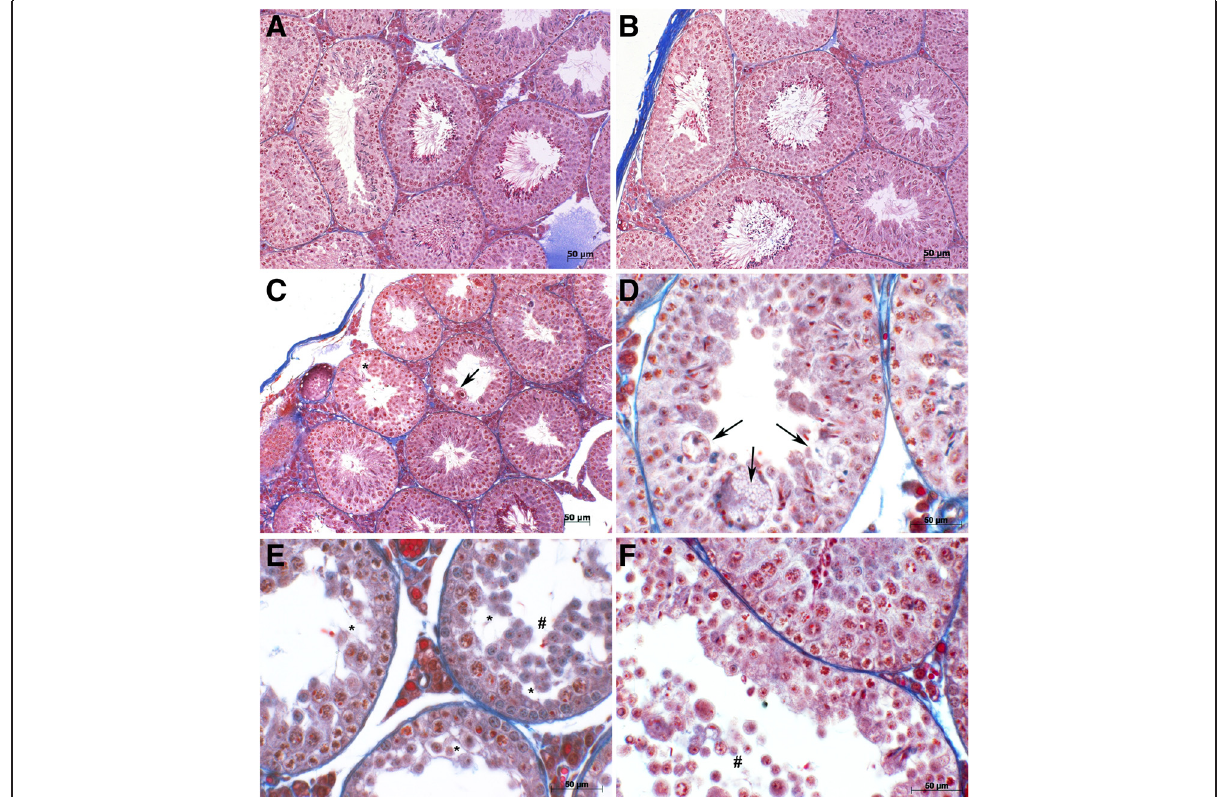
Figure 1 Morphological analysis of the seminiferous epithelium of male adult mice treated with BPP-10c and captopril. Photomicrographs of the seminiferous tubules of male adult mice treated with vehicle (A) , captopril (B) and BPP-10c (C, D, E, F) using Mallory ’ s trichrome stain. The seminiferous tubule morphological data obtained from the animals treated with BPP-10c indicated the presence of atypical cells in the lumen (arrow), disruption of the epithelium (*), and a loss of elongated spermatids (#). No alteration was observed in the seminiferous epithelium from mice treated with captopril or